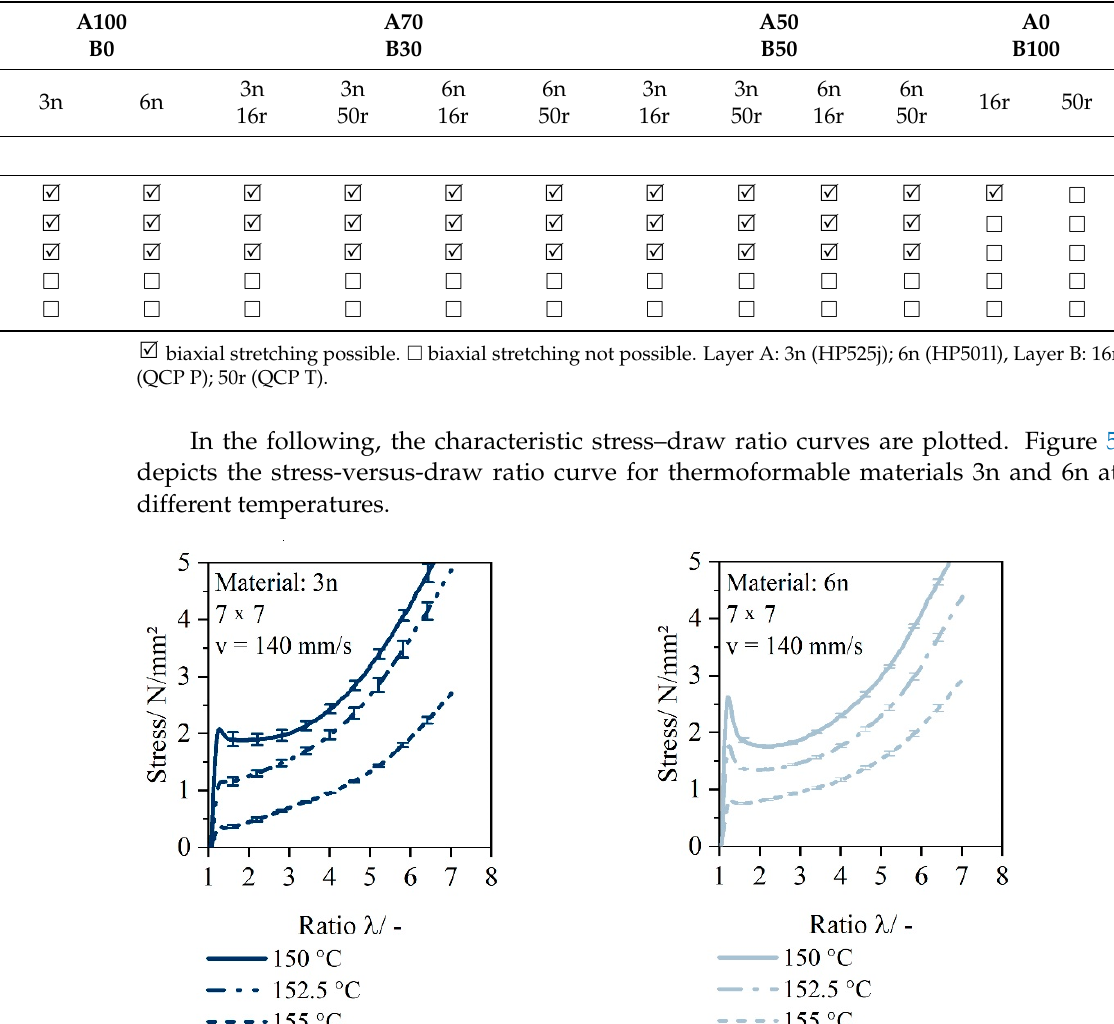
Figure 5. Stress–draw ratio curve of 3n (HP525j) at different temperatures 150 °C, 152,5 °C and 155 °C ( a ); Stress–draw ratio curve of 6n (HP501l) at different temperatures 150 °C, 152,5 °C and 155 °C ( b ).